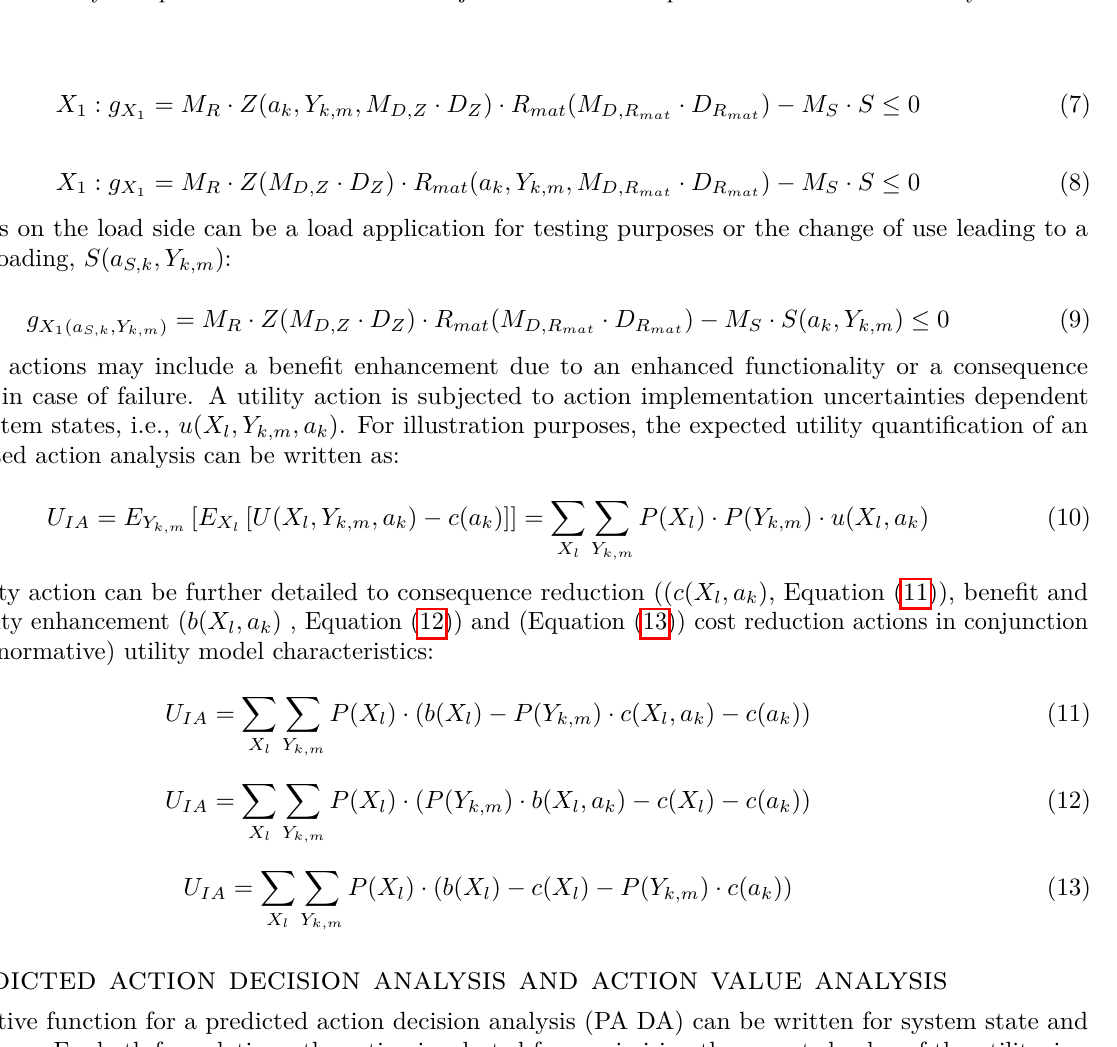
Figure 1. System performance functions and objective functions for predicted action decision